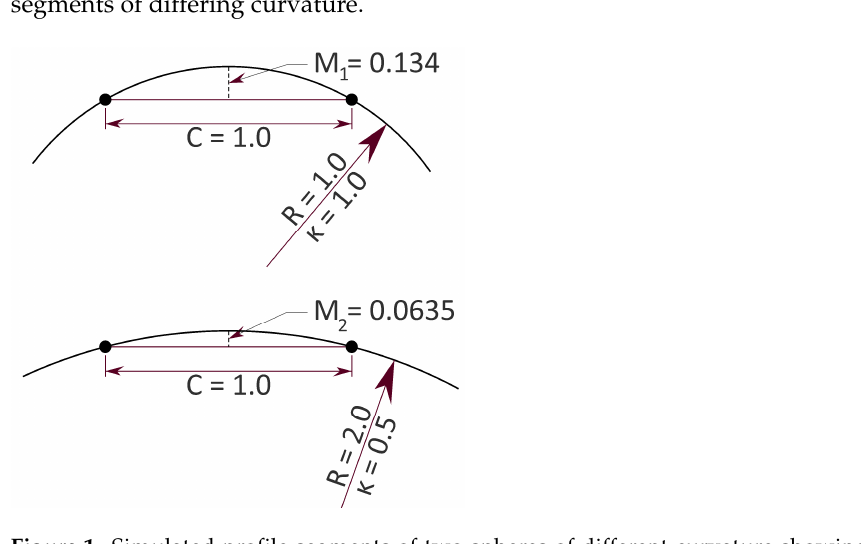
Figure 1. Simulated profile segments of two spheres of different curvature showing two sample points on each sphere and the maximum approximation error at the middle ordinant, M.